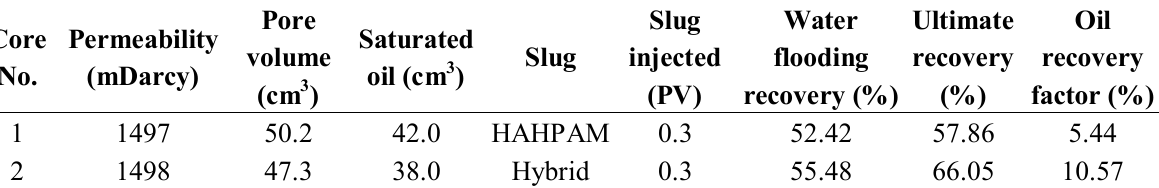
Table 1. Core parameters, displacement process and recovery factors.